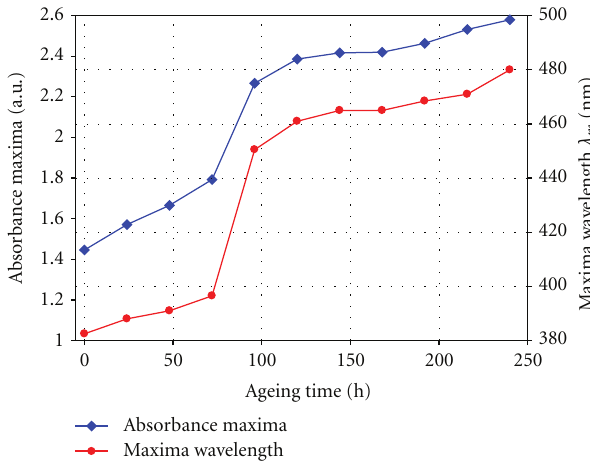
Figure 12: UV-VIS absorbance maxima and maxima-wavelength variation with ageing for